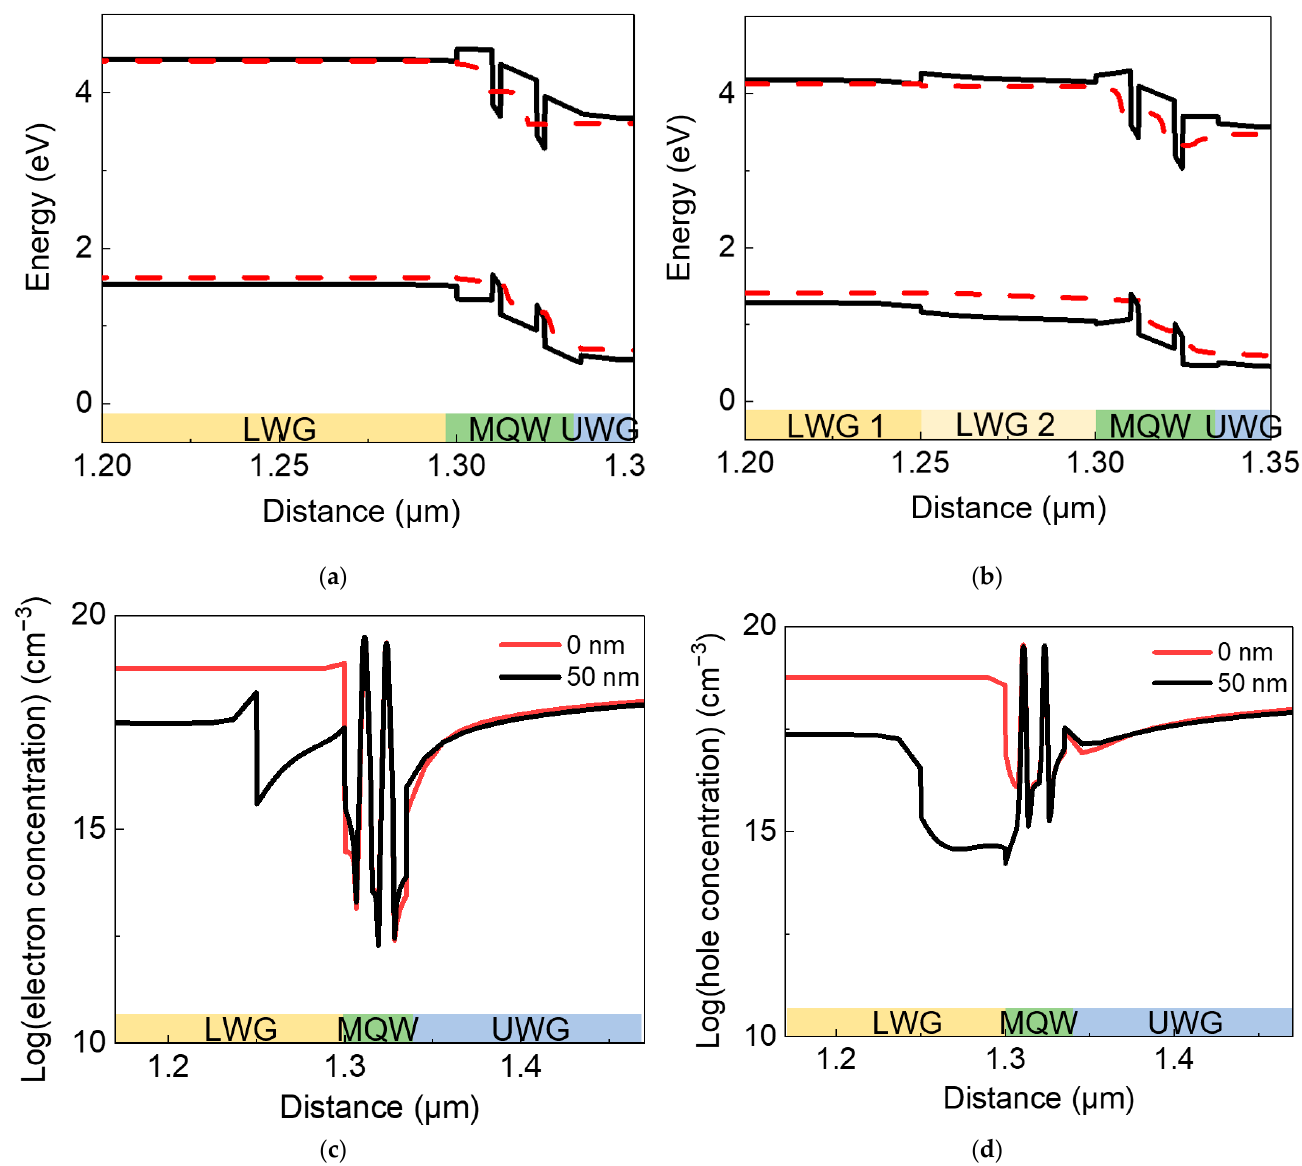
Figure 8. Energy band diagrams of ( a ) conventional single layer LWG structure and ( b ) composite structure with a 50 nm thick In0.04 Ga0.96 N inserting layer at an injection current of 1000 mA, where the black solid lines represent conduction and valence bands, and red dashed lines represent quasi-Ferimi level. ( c ) Electron concentration and ( d ) hole concentration distribution in two LDs with different LWG structures with or without an inserting layer at an injection current of 1000 mA.